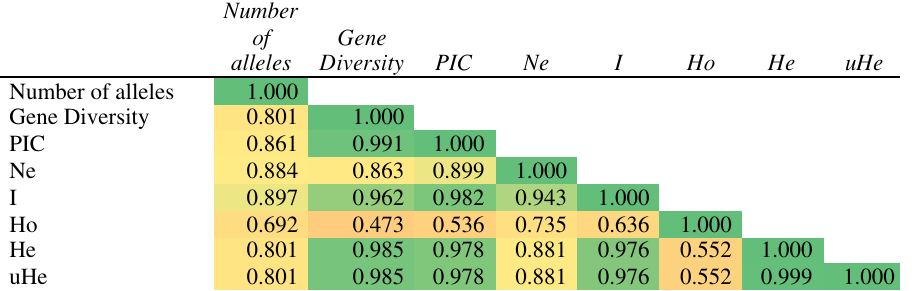
Figure 6. Correlation coefficient between different genetic diversity indices.